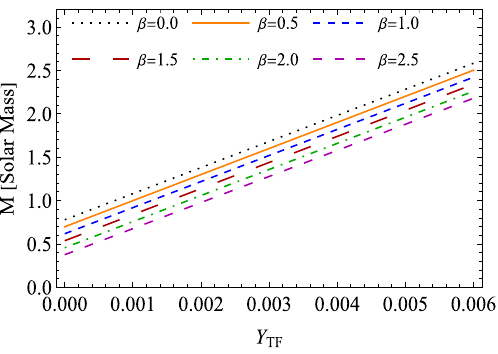
Fig. 4 The variation of Mass (M/ M (cid:8) ) versus complexity factor Y TF for solution 5.1